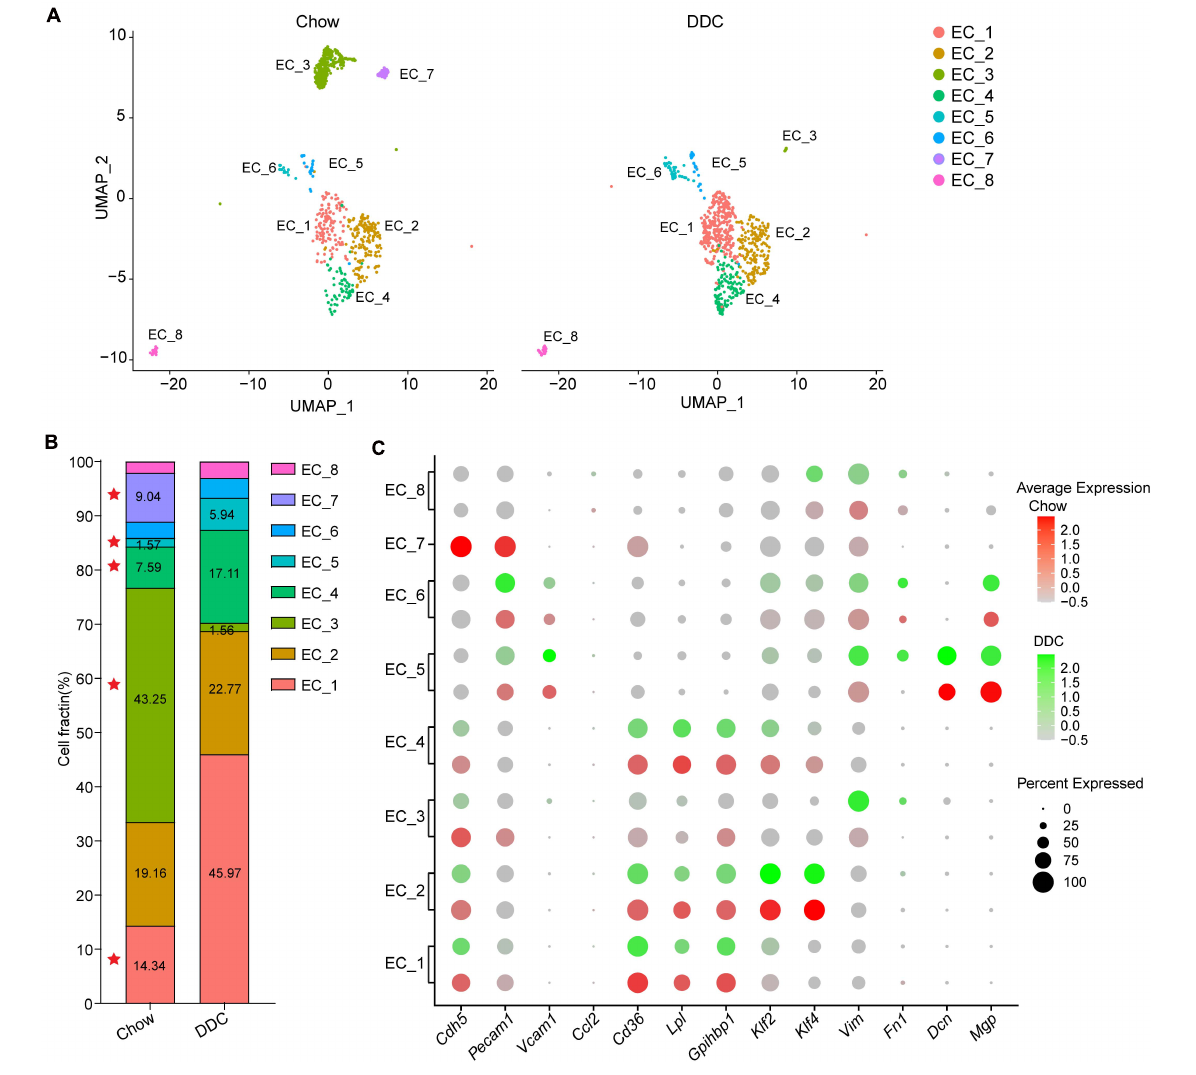
FIGURE 4 | Diet-induced changes in endothelial cell subpopulations. (A) , UMAP plot of EC clusters from Chow ( n = 830) and DDC ( n = 707) groups (n is the number of cells qualified for analysis in each group). Colors denote different EC clusters. (B) , Cell cluster percentages across two experimental groups (Chow and DDC). (C) , Dot plot showing the expression of EC marker genes and genes associated with inflammation, lipid metabolism, stress response and endothelial-mesenchymal transition (EndMT) in all EC clusters across the two experimental